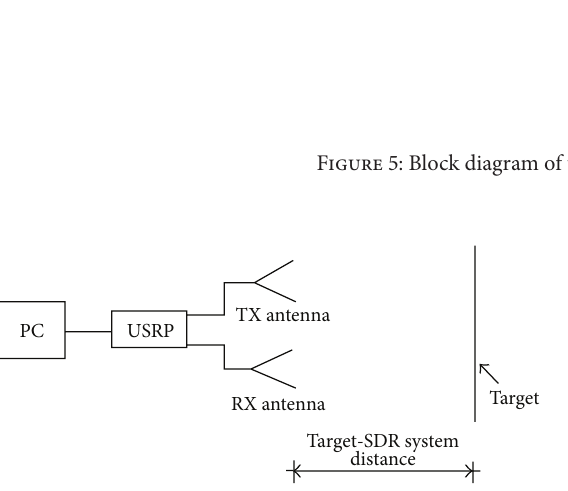
Figure 6: Scheme of the basic system for outdoor test.